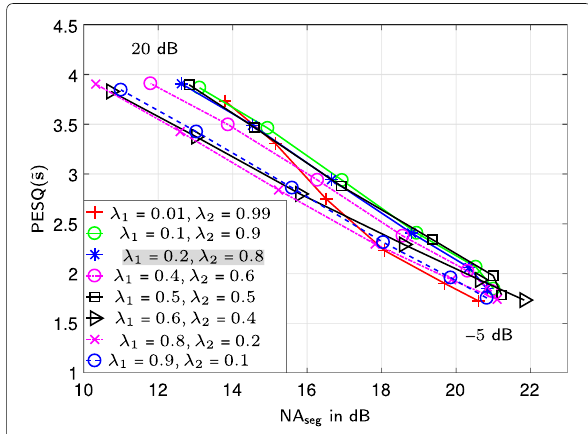
Fig. 8 Noise attenuation NA seg vs. speech component quality PESQ s for different parameters 1 and 2 for the baseline PW- PESQ (5) on 12 . 5 % of the validation set . From top to bottom, the markers are corresponding to six SNR conditions from 20 to 5dB with a step size of 5dB. The selected setting is gray-shaded in the legend